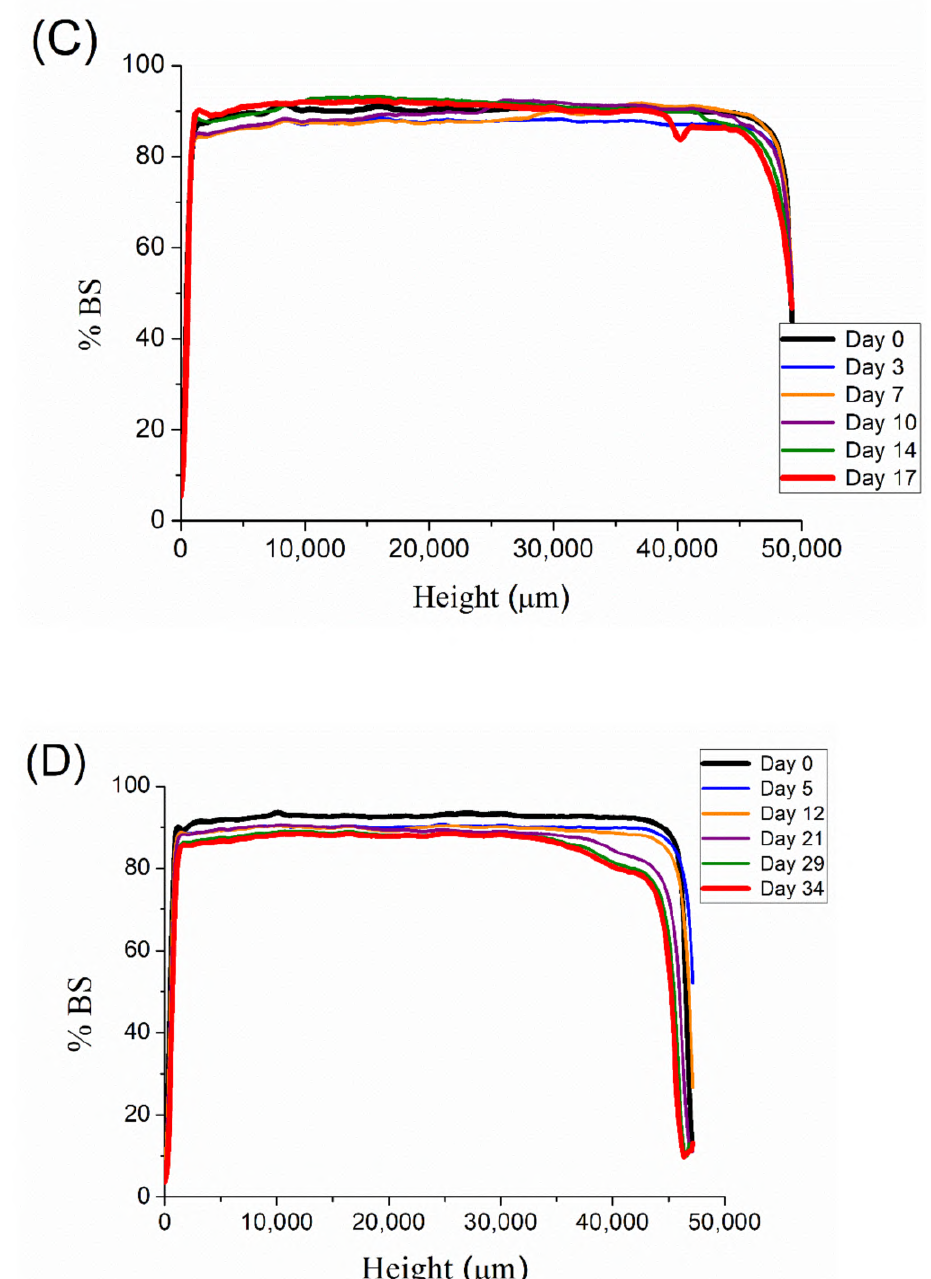
Figure 6. ( A ). Backscattering measurements with the height of the measuring cell as a function of aging time for emulsion containing 0.1 wt.% of diutan gum. ( B ). Backscattering measurements with the height of the measuring cell as a function of aging time for emulsion containing 0.2 wt.% of diutan gum. ( C ). Backscattering measurements with the height of the measuring cell as a function of aging time for emulsion containing 0.3 wt.% of diutan gum. ( D ). Backscattering measurements with the height of the measuring cell as a function of aging time for emulsion containing 0.4 wt.% of diutan